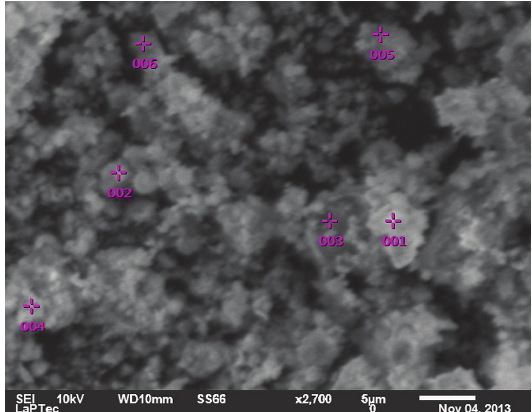
Figure 2. SEM micrograph indicating the points analyzed by EDS.